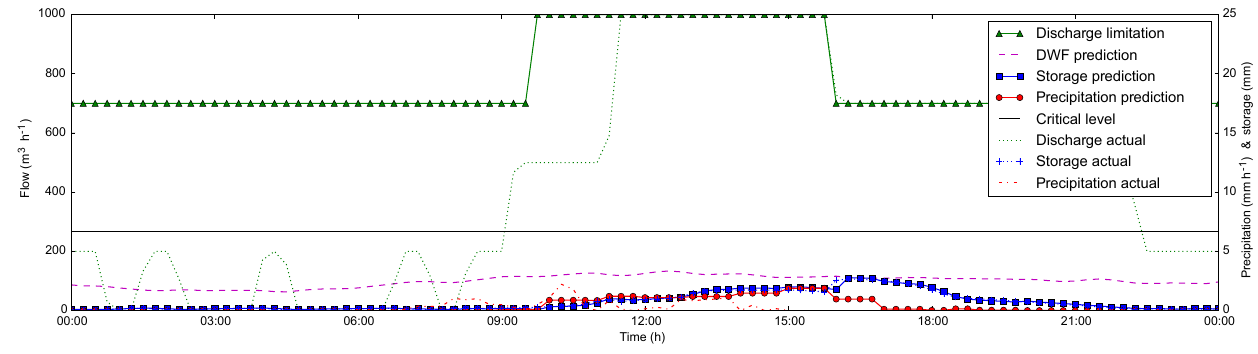
Figure 3. Example of bypass reduction with a conservative approach at WWTP Bennekom for the event of 4 March (Icke et al.,